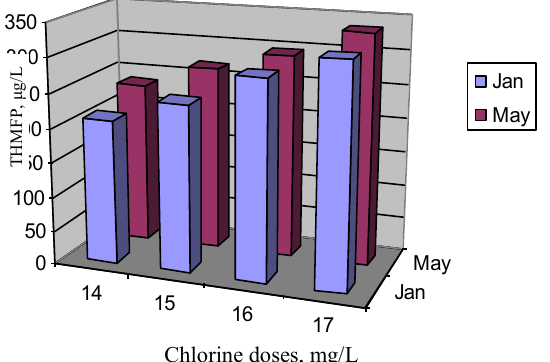
Figure 1. Seasonal variation of THMFP for Jajmau ground water at different chlorine doses.